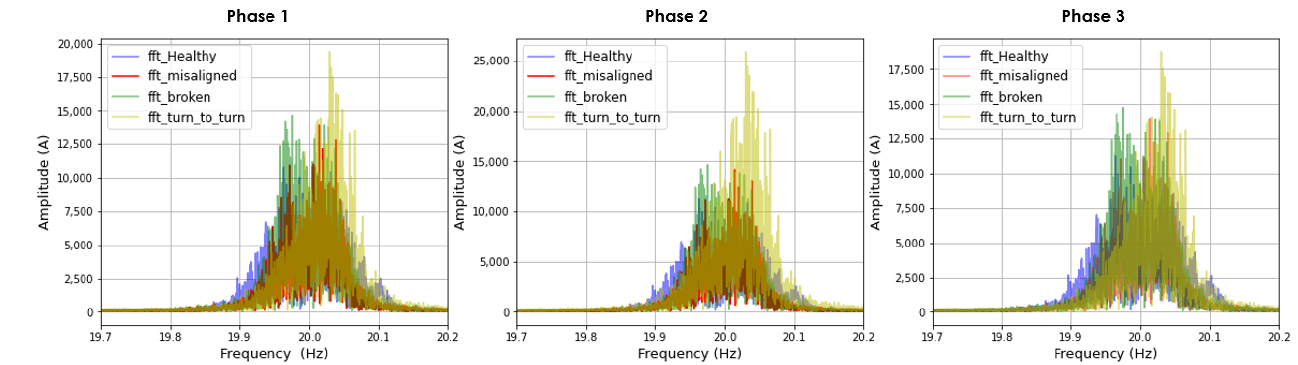
Figure 8. A 3-phase motor current signal FFT spectral of the various operating